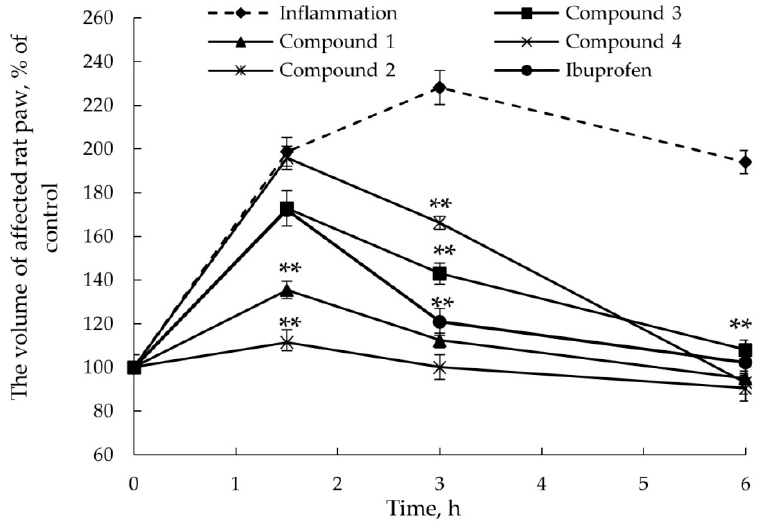
Figure 1. AITC-induced edema. Time dependence of the volume of affected rat paw after topical delivery (2% w / w ointment) of esters 1 – 4 and ibuprofen. ** p < 0.01 compared with vehicle-treated group. One-way analysis of variance (ANOVA) followed by Tukey’s post hoc comparison.